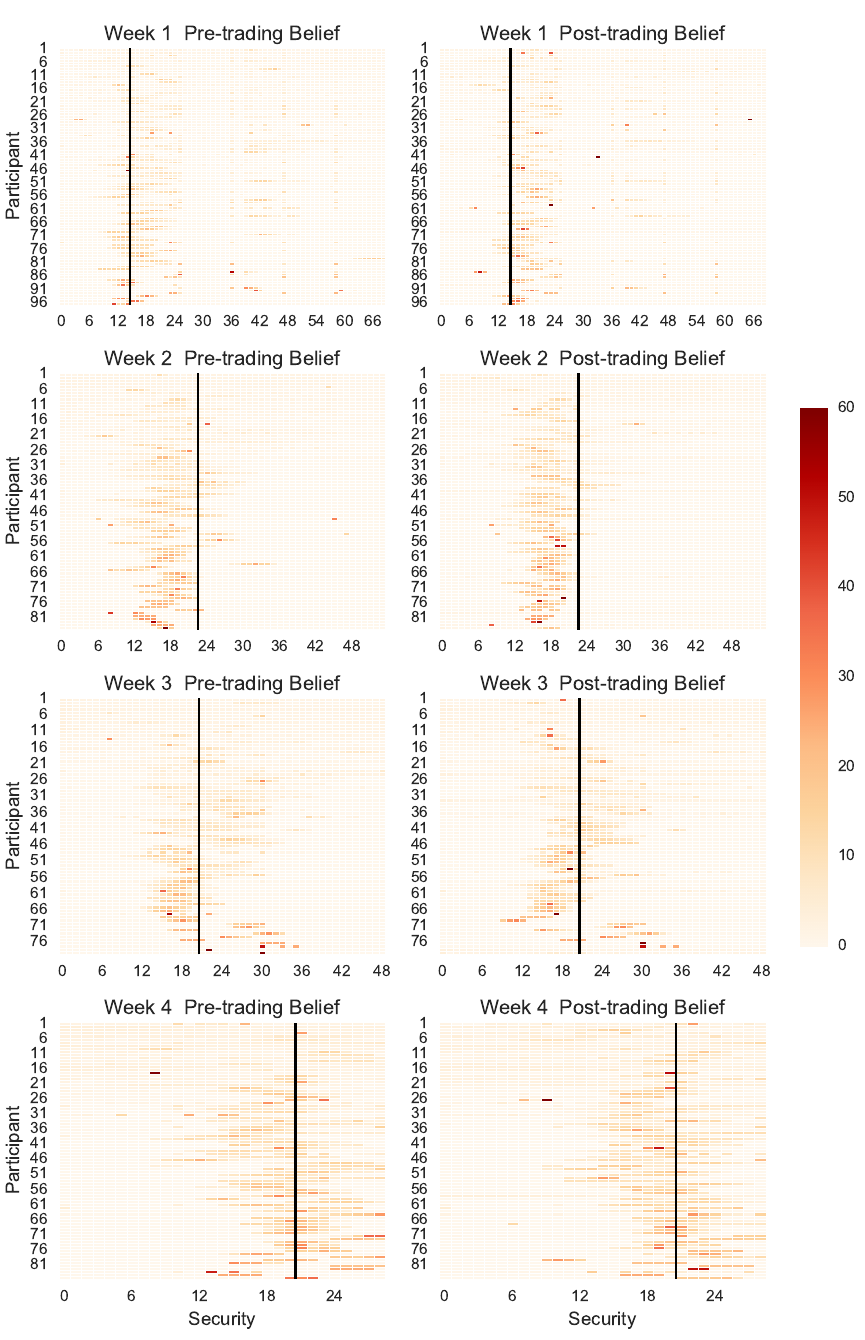
Figure 4: Left: Individual pre-trading beliefs; Right: individual post-trading beliefs. The black line indicates the security that paid